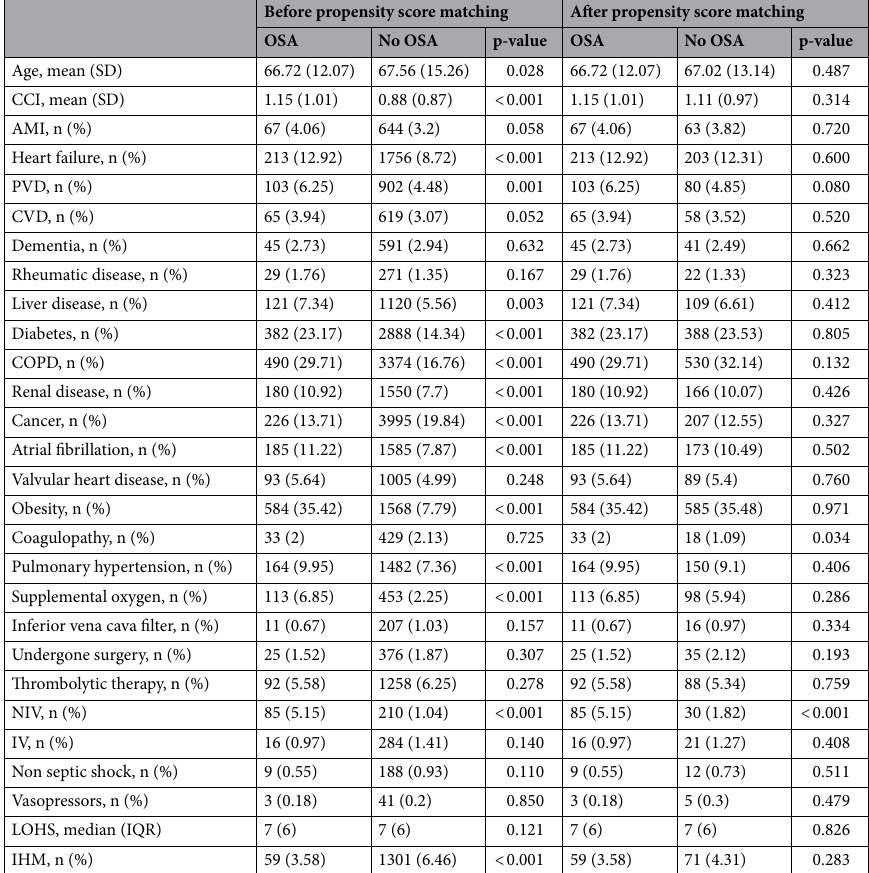
Table 2. Prevalence of specific comorbid conditions, therapeutic procedures, and hospital outcomes in men hospitalized with pulmonary embolism (PE) according to the presence of obstructive sleep apnea in Spain from 2016 to 2018 before and after propensity score matching. OSA Obstructive sleep apnea, CCI Charlson comorbidity index, AMI acute myocardial infarction, PVD peripheral vascular disease, CVD cerebrovascular disease, COPD chronic obstructive pulmonary disease, NIV non-invasive ventilation, IV invasive ventilation, LOHS length of hospital stay, IHM in-hospital mortality, SD standard deviation, IQR interquartile range. p value for comparison of men and women with